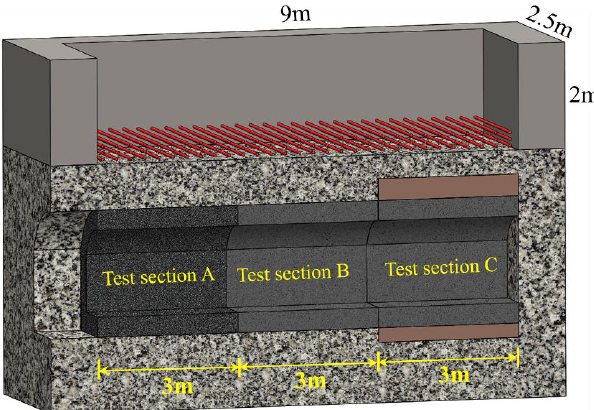
Figure 2. The engineering layout of the test sections.